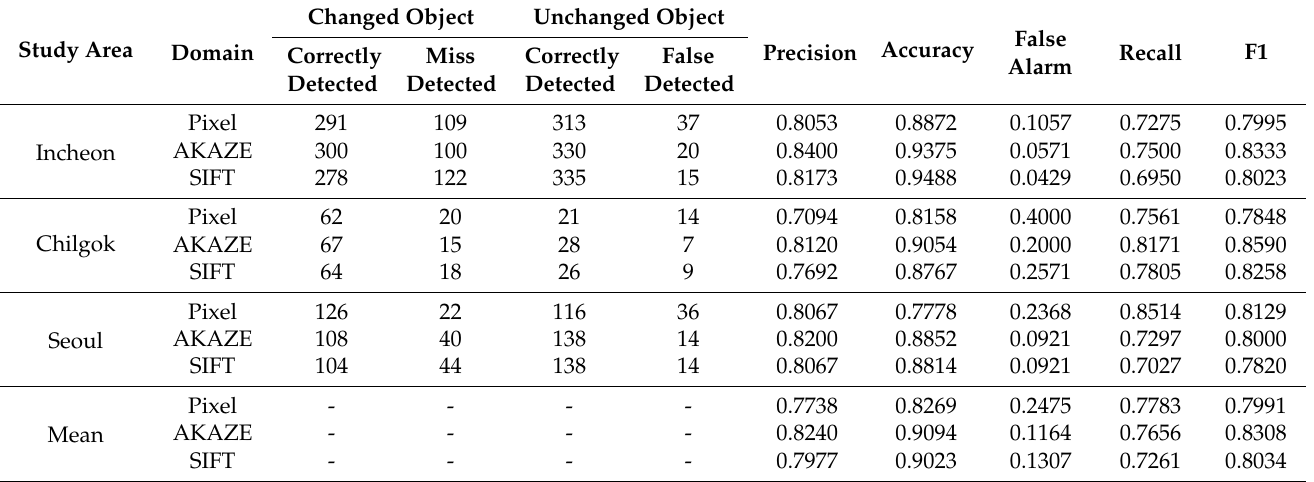
Pixel AKAZE SIFT Figure 12. The ROC curves for pixel-based and feature point-based approaches with respect to the number of object changes in ( a ) Incheon, ( b ) Chilgok, and ( c ) Seoul. X -axis represents false alarm rate and Y -axis recall. Table 7. Performance of change detection results in the object domain.